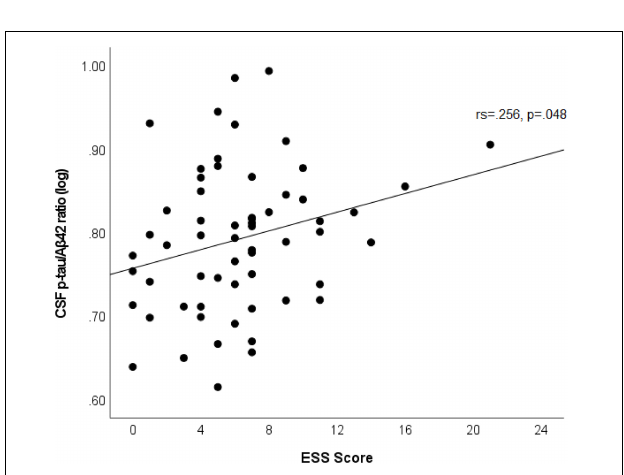
FIGURE 2 | Scatterplot shows an association between ESS scores and log of CSF p-tau/A β 42 in participants with abnormal ratio (amyloid positive). Best fit line is displayed, with the Spearman’s correlation coefficient and its p